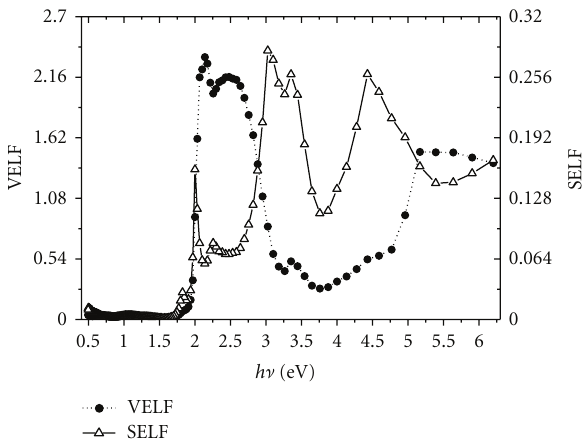
Figure 10: Molar extinction coe ffi cient versus wave number (circle point) for as-deposited thin films of (PTCDI) fitted using the Gaussian model (solid line) assuming two oscillator components. The dashed lines present the decomposition of the molar extinction spectrum on particular oscillatory transitions.